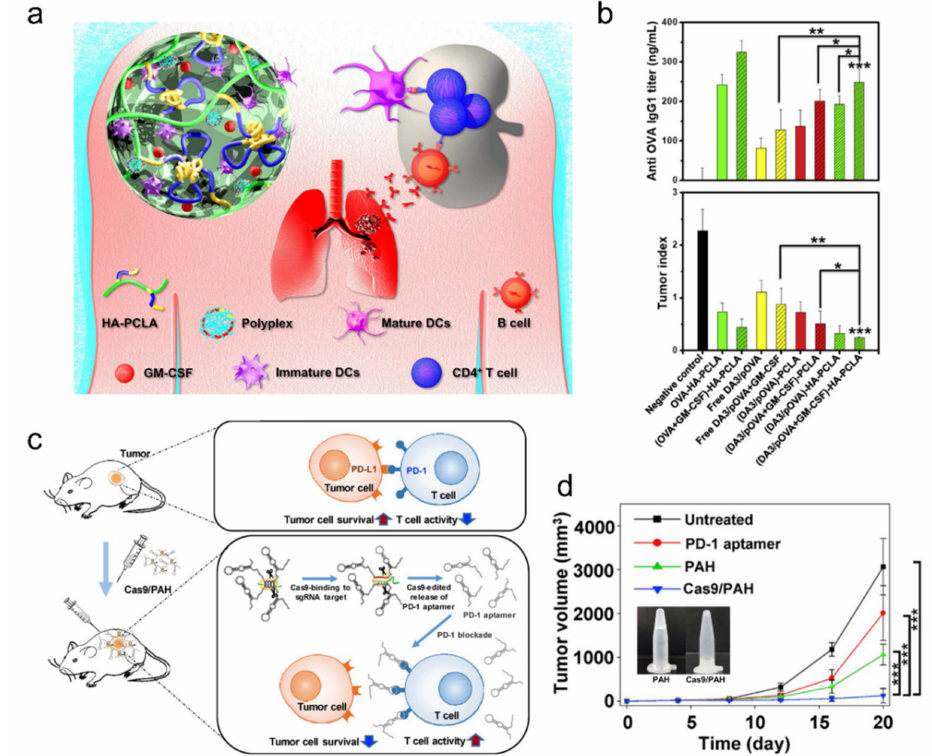
Figure 3. Hydrogel drug delivery platforms with nucleic acid additives. ( a , b ) Injectable cancer DNA vaccine hydrogel. ( b ) Demonstration of humoral anti-OVA immune response (production of anti-OVA IgG1 antibody) in BALB/c mice induced by various injected DNA polyplex OVA; adapted with permission from [52]. Copyright 2020 Elsevier. ( c , d ) Anti-PD-1 aptamer delivery using injectable polyaptamer hydrogel; adapted with permission from [54]. Copyright 2019 Elsevier. Cas9 induces polyaptamer hydrogel dissociation and tumor local blockade of PD-1 checkpoint on T cells, thus inducing higher antitumor effect ( d